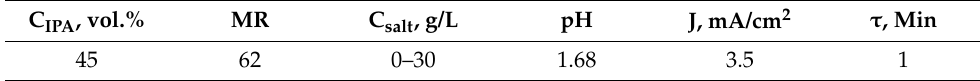
Table 1. The parameters of the reaction medium for determining the salt effect. C IPA ,